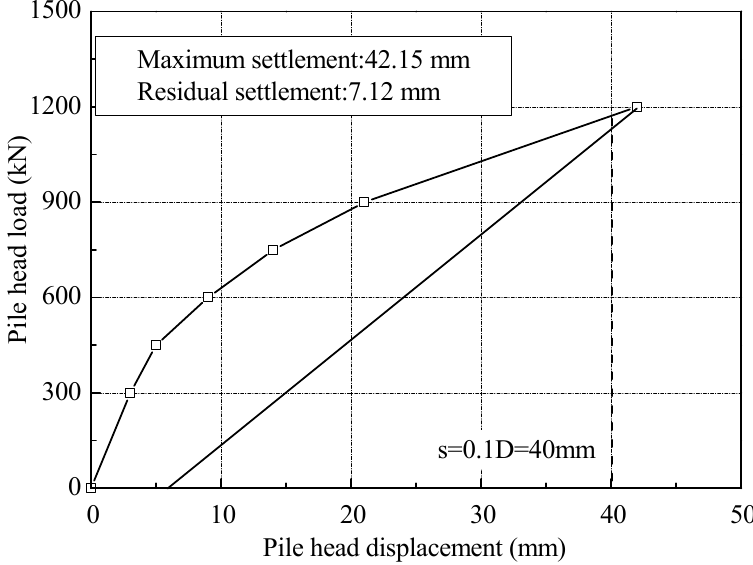
Figure 13. Load-settlement curve for static loading test of T2.